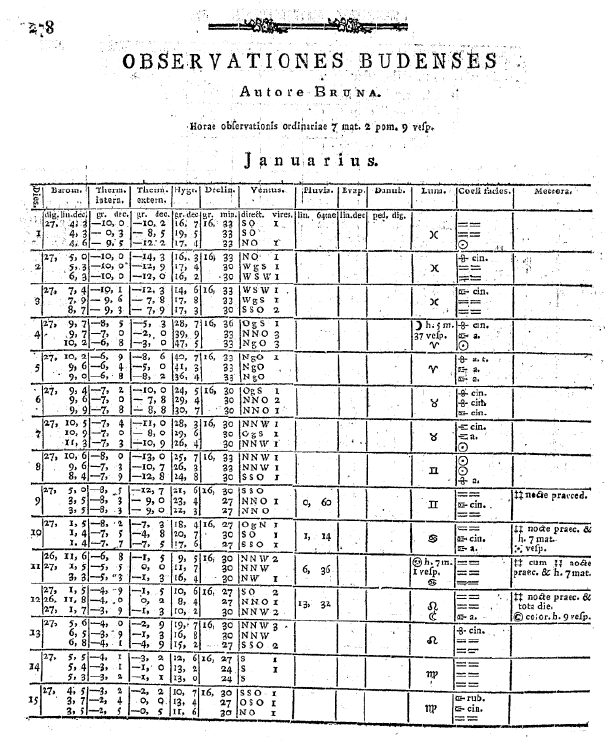
Figure 2. Example of a typical table of sub-daily measurements for the period from 1 to 15 January 1789, in this case showing observa- tions for Budapest, recorded by Ferenc Xavér Bruna (Ephemerides, 1795, 1791, p.